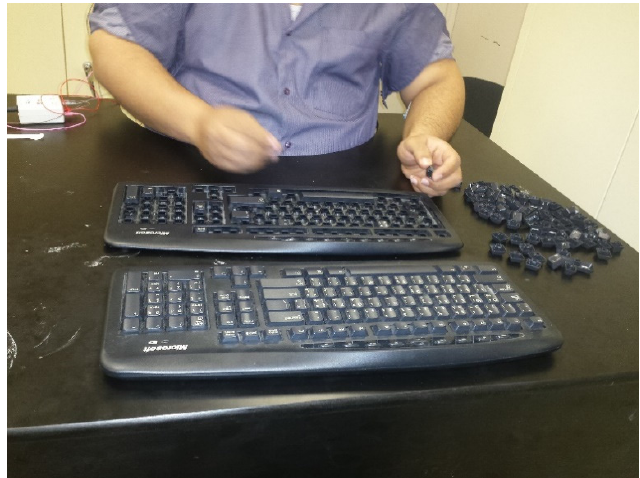
Figure 1. The assembly task of the